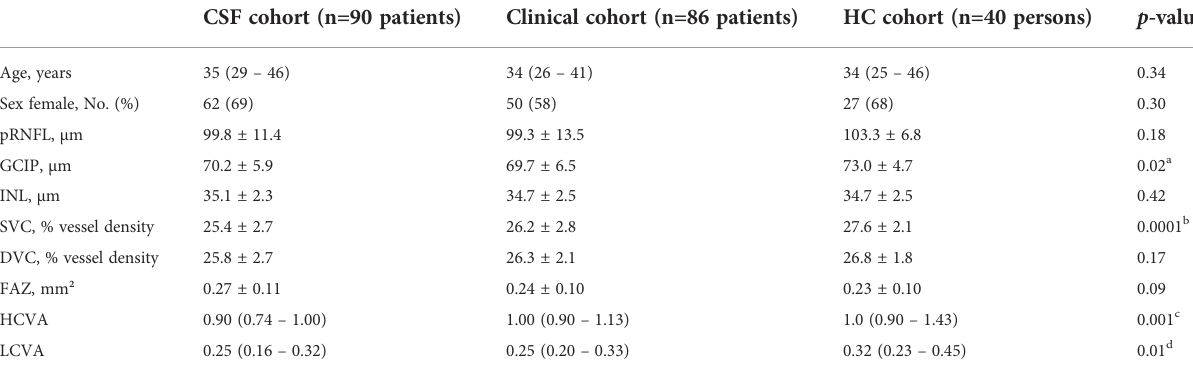
TABLE 3 OCT, OCT-A diagnostics and visual function in all study cohorts at study enrollment. CSF cohort (n=90